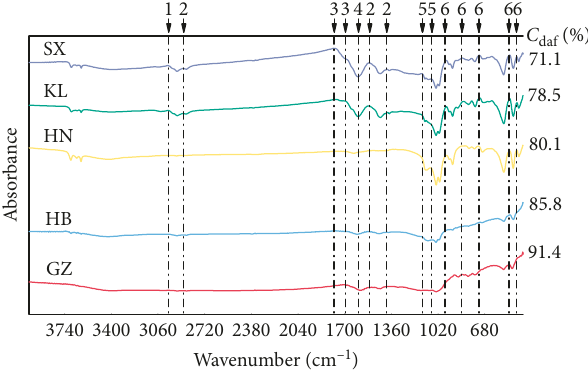
Figure 3: Infrared spectrogram of five coal samples. Attribution of characteristic peak positions is descried as follows: (1) aromatic hydrocarbon CH; (2) aliphatic CH 2 or CH 3 stretching vibration; (3) aromatic carbonyl/carboxyl groups (C O); (4) aromatic nucleus (cid:31) (C C); (5) phenolic deformation C ─ O ─ C (stretching); (6) aromatic (cid:31) CH (out-plane